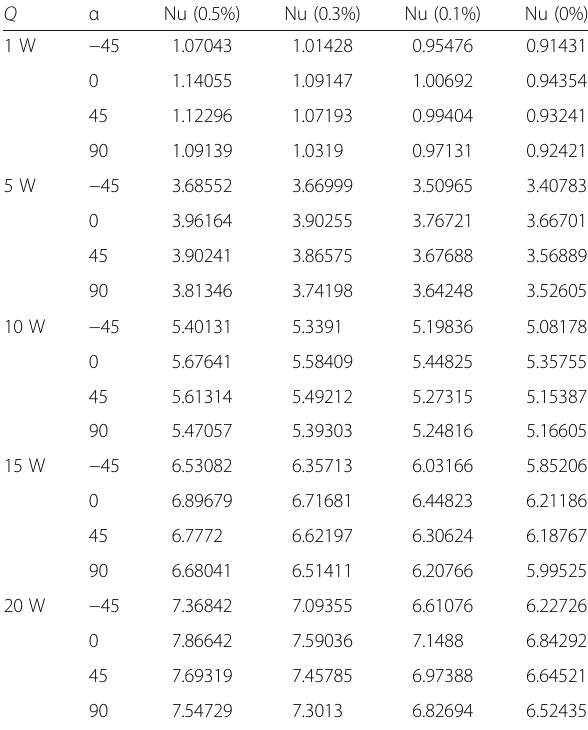
Table 2 Nusselt numbers ( A = 1:1). Nusselt number values based on Fig. 14 ( A = 1:1)